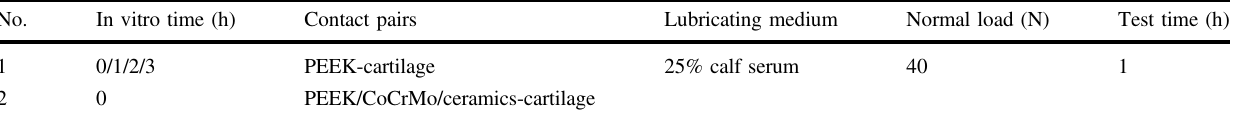
Table 2 Creep test parameters